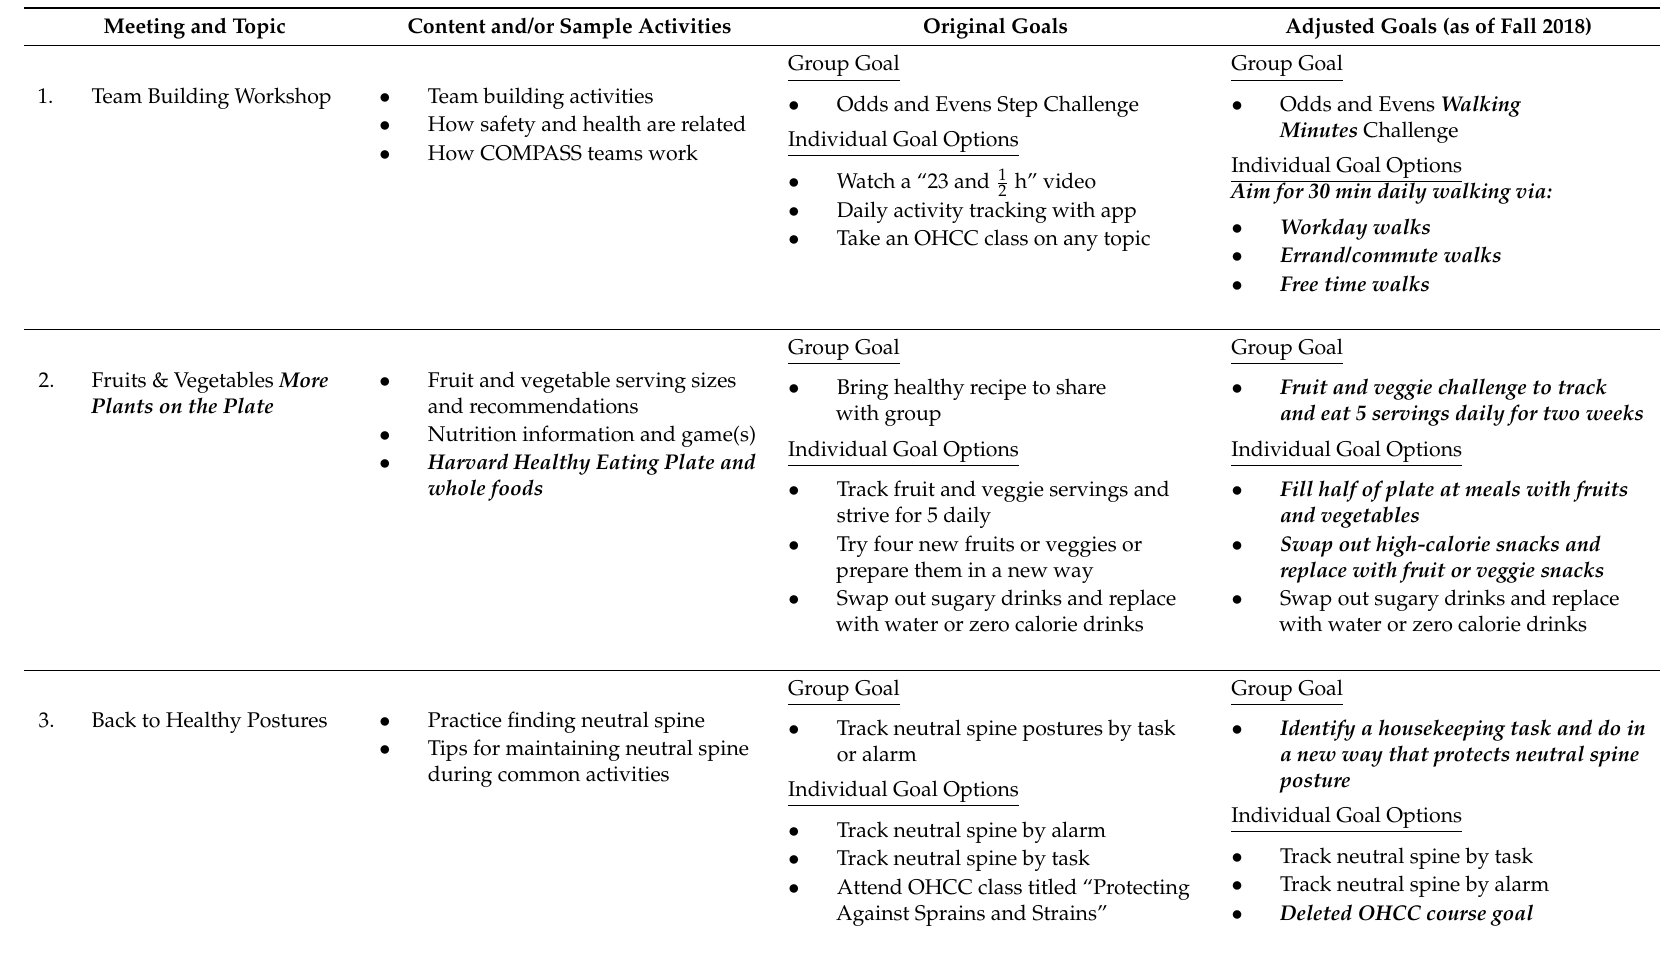
Table 1. COMmunity of Practice And Safety Support (COMPASS) guidebook one: Topics with original and adapted goal options (adaptations are in bold italics